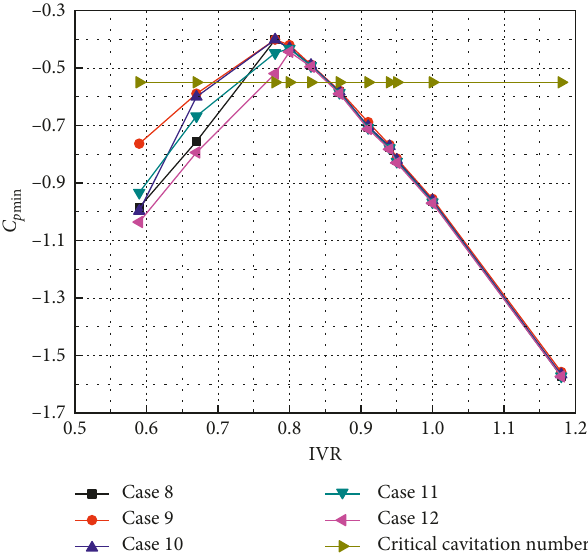
Figure 27: The minimum cavitation number C lip